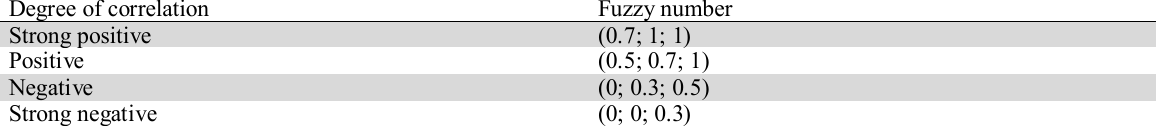
Degree of correlation, graphic symbols and corresponding fuzzy numbers Degree of correlation Fuzzy number Strong